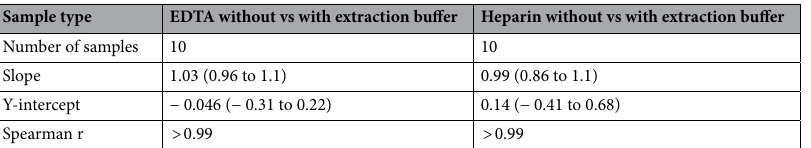
Table 2. Comparison of Elecsys ECLIA N-antigen measurements in EDTA/Heparin plasma without vs with addition of the extraction buffer. (95% confidence intervals).